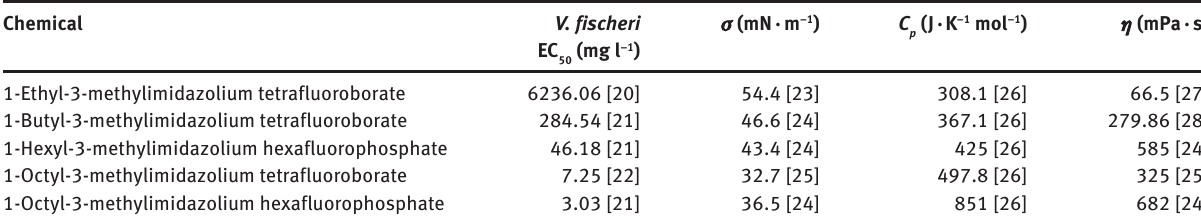
Table 3: Physicochemical and toxicological ( Vibrio fischeri ) properties used in the QSAR for previously studied ILs. Chemical